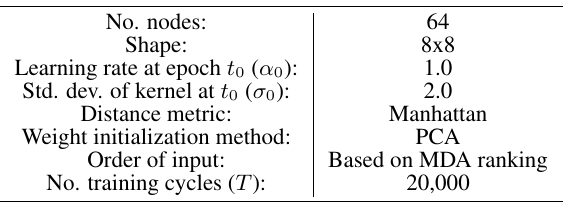
Table 1. Parameters for the Self-organizing